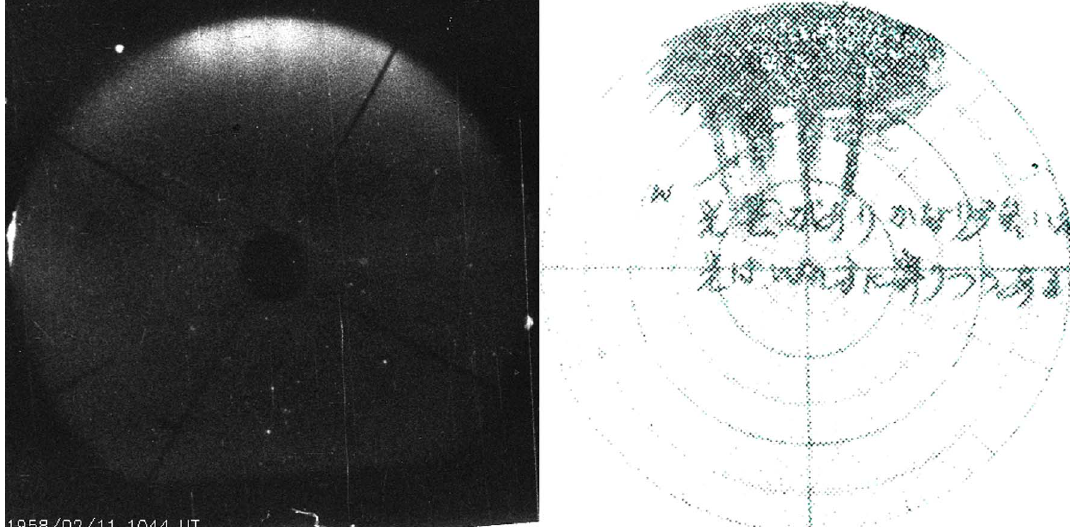
Fig. 1. Sample photograph (left, at 1044 UT) and hand-made sketch (right, at 1037 UT) of the auroras, as observed at Memambetsu Magnetic Observatory on February 11, 1958. Both images are in the all-sky format, where zenith is the center and geographic north is to the